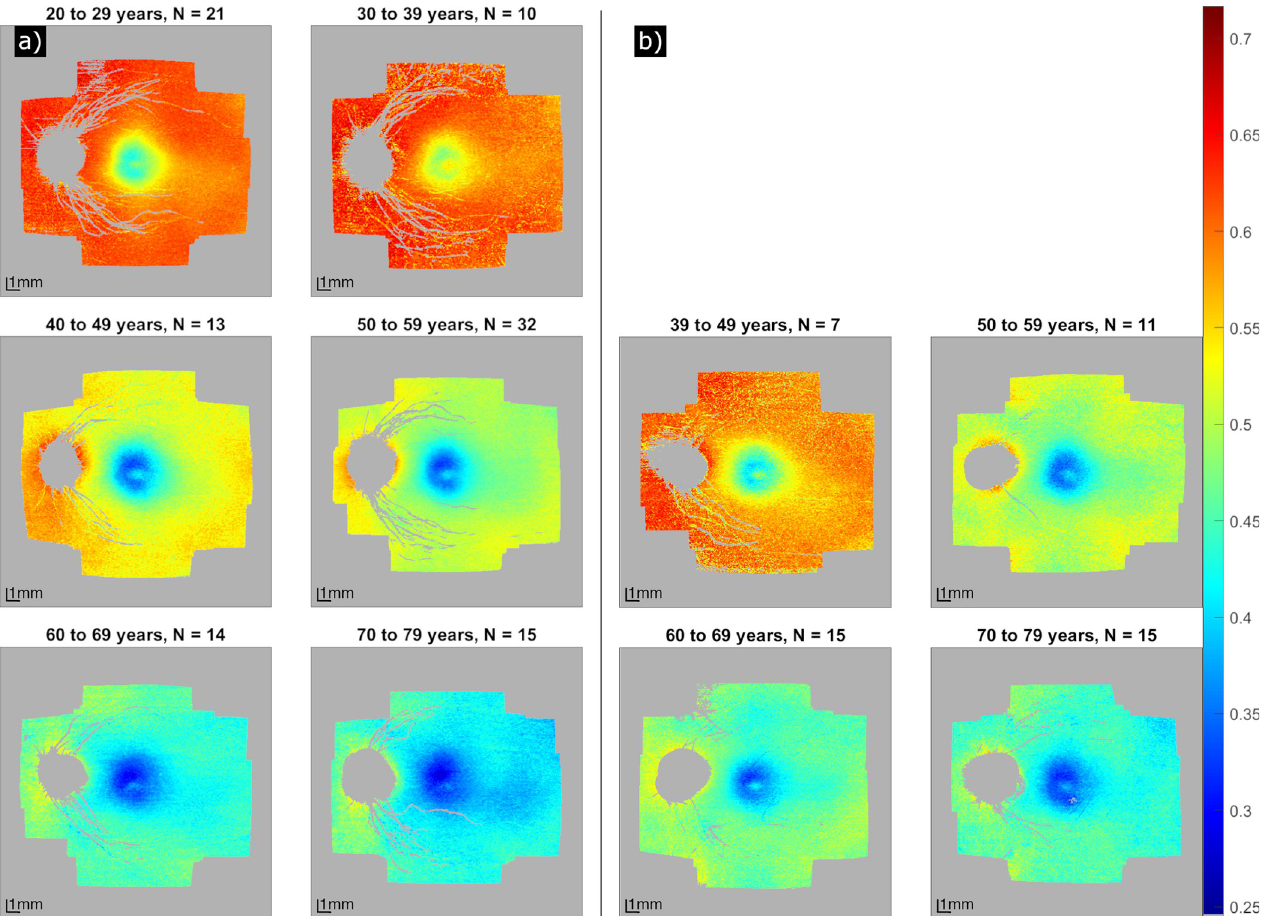
Fig 4. DOPU en-face maps in a large field of view of healthy volunteers (a) and glaucoma patients (b), for different age groups. The number N of participants per map is depicted in the heading. The color values correspond to DOPU (low values: Strong depolarization), gray values indicate pixels that have been omitted from the